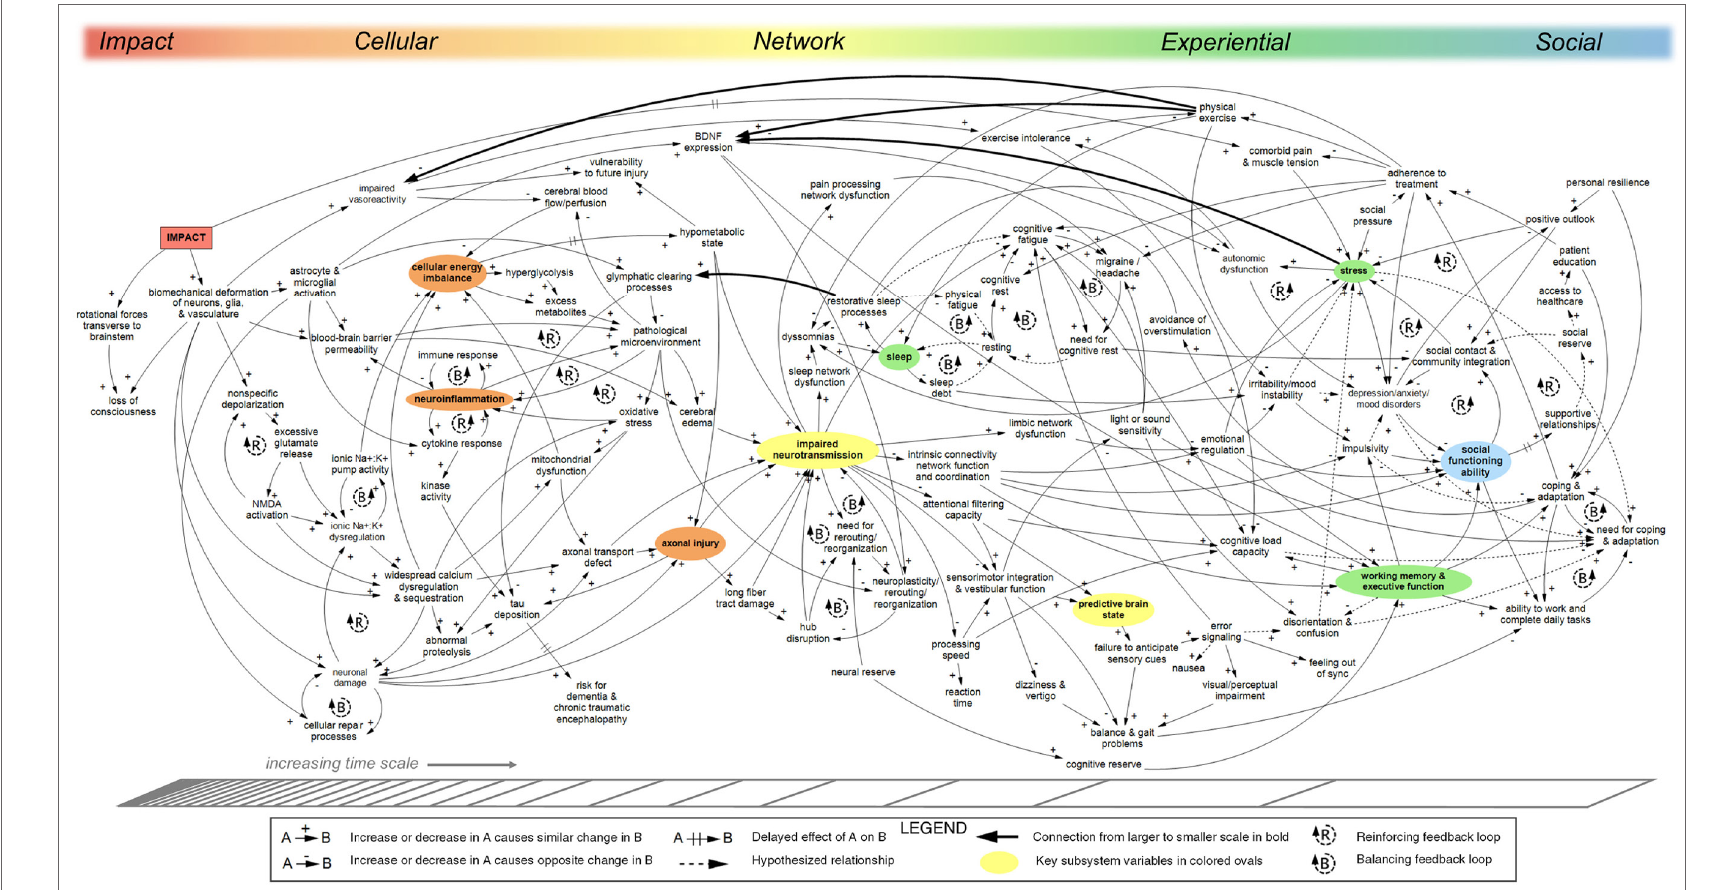
FigUre 1 | Causal-loop diagram (CLD) of concussion pathophysiology, persistence, and recovery. The model shows causal relationships between factors influencing recovery from impact concussion. Reinforcing feedback loops characterized by exponential growth or decline are indicated with R-loop symbols; balancing feedback loops for repair, replenishing, or homeostatic processes that strive to move the systems toward a set point are indicated with B-loop symbols. Hash marks across an arrow indicate a significant delay. Approximate organization across biological scales is shown on the top axis; change in time scale is indicated on the bottom axis. Key indicator variables representative of subsections of the model are shown in colors corresponding to the top axis. Solid arrows indicate relationships identified in the literature. Relationships not supported directly by published literature are shown with dotted arrows. “Downscale” connections linking variables at larger scales to variables at smaller scales are indicated in bold. The model was developed qualitatively based on iterative review of relevant literature, expert interviews, and expert review. A web-based interactive version of this diagram can be found at www.dynamicsofconcussion.com. Supporting documentation can be found in the Evidence Table (Table S2 in Supplementary Material). Diagram rendered in MapSys (Simtegra Version